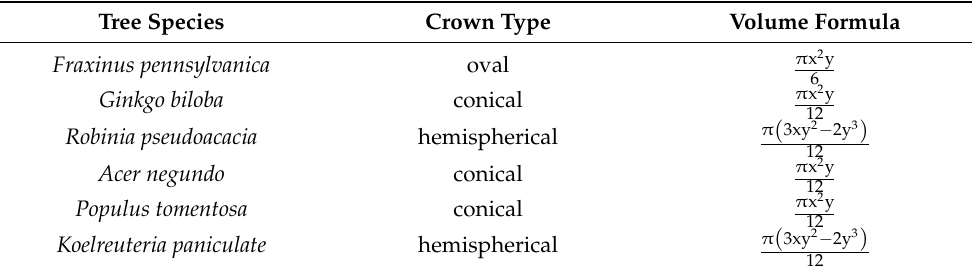
Table 3. Approximate geometry and volume calculation formulas for different tree